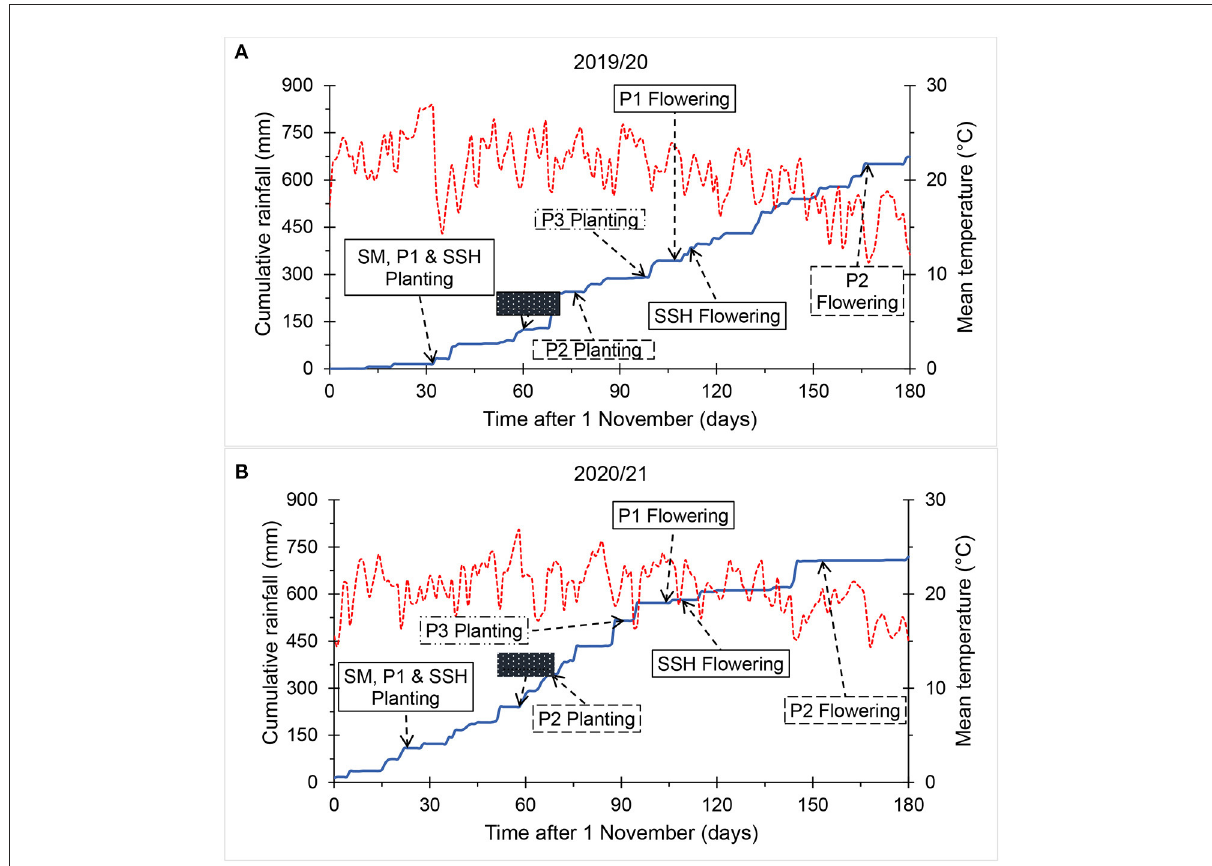
FIGURE2 Cumulative daily rainfall, average daily temperature, and agronomic management practices during (A) 2019/20 and (B) 2020/2021 growing seasons. Red dotted line is the average daily air temperature, blue line is the cumulative rainfall since 1 November, shaded block is when in-field rainwater harvesting basins were modified. SM, sole maize; SSH, sole sunn hemp; P1, simultaneous sunn hemp intercropping; P2, intercropping sunn hemp at the early maize vegetative growth stage; P3, intercropping sunn hemp at the late maize vegetative growth